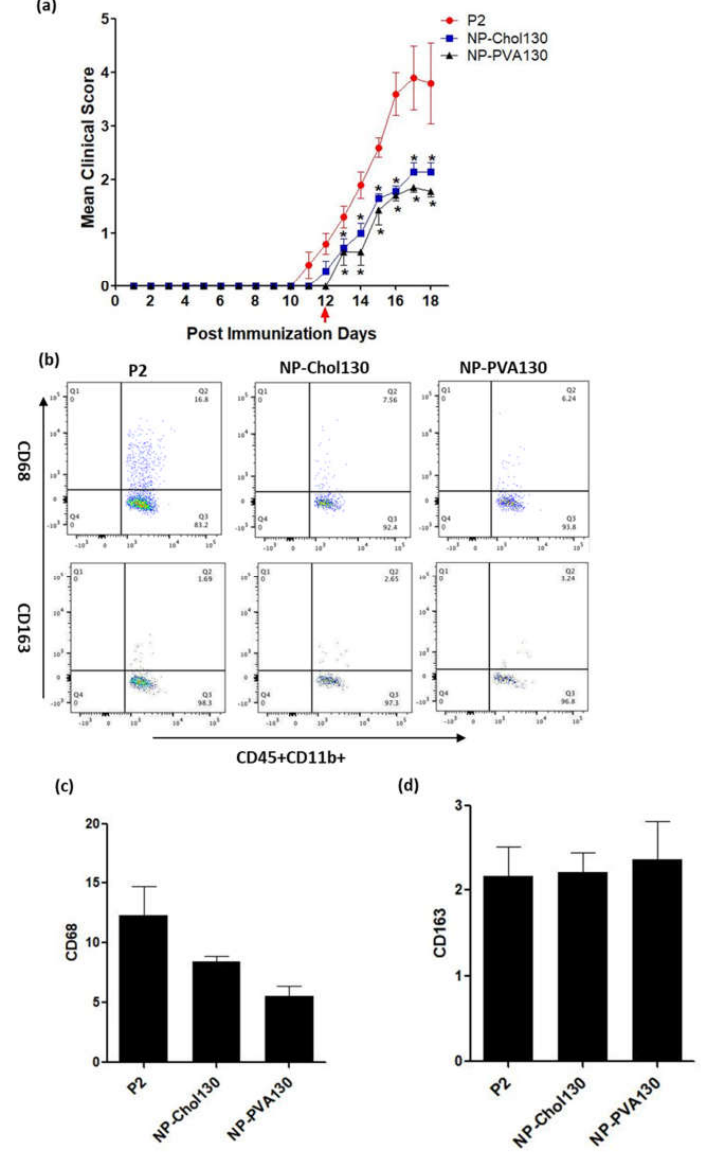
Figure 3. Surfactant modification improved the disease course of EAN. ( a ) Mean clinical scores (±S.E.M.) post-immunization with P2-peptide and treatment with surfactant modified NPs. Symptoms of experimental autoimmune neuritis (EAN) appeared between 10–12 days of post- immunization in each group P2 ( n = 5), NP-Chol130 ( n = 7), NP-PVA130 ( n = 7). Each group was administered with a 9 mg/kg dose of NP-Chol130 and NP-PVA130 at the early onset of disease. Arrow indicates the start of NPs treatment. Dot plots of flow cytometric representation of CD68 and CD163 percentages in CD11b population ( b ) Spleen mononuclear cells (MNCs) were isolated from the P2-Peptide and treatment groups at day 17 of post-immunizations. With flow cytometry, these monocytes were identified by gating against the side and forward scatter. The percentage (Q2) of CD68 and CD163 of each NPs type was determined and compared with the P2-peptide group. A distinct reduced percentage of activated macrophages (CD11b+CD68+) was observed with the treatment of NP-PVA130. A slightly higher CD11b+CD163 cell percentage was observed with the treatment of NP-PVA130. No significant differences were observed between the respec- tive groups. Flow cytometry data represents the percentage expression of activated macrophages ( c ), (CD11b+CD68+) ( d ), CD11b+CD163 of both NP types and P2-peptide treated group comprising of three female Lewis rats per group. For clinical scores Mann-Whitney nonparametric U -test, for FACS one-way ANOVA with a Bonferroni post-test, * p ≤